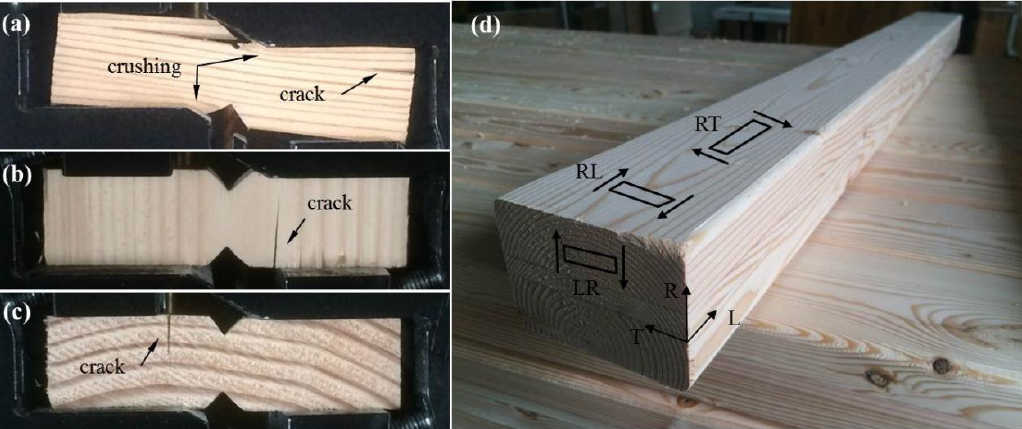
Figure 1. Premature failure in specimens without tabs at room temperature: ( a ) RT; ( b ) RL; ( c ) LR; ( d ) Illustration of shear plane.